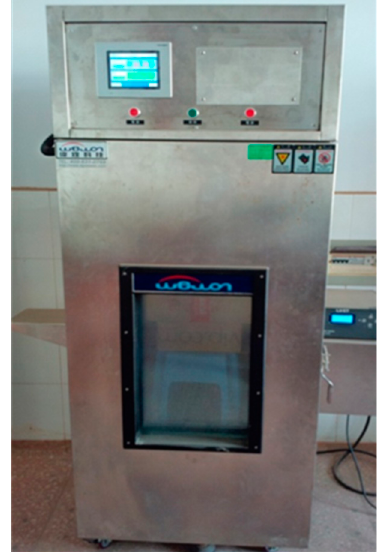
Figure 2. Ultraviolet (UV) environment chamber.